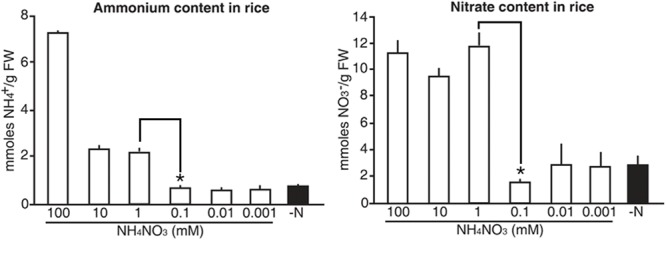
Internal levels of ammonium and nitrate that vary upon exogenous application of N sources in rice. Levels of ammonium and nitrate in wild type rice plants grown on GM–N (growth media –N) for 4 days followed by +N at 0, 0.001, 0.01, 0.1, 1, 10, or 100 mM ammonium nitrate for 1 day. Data shown are the mean + SD of two biological and three technical replicates. Asterisks indicate significant differences based on a 95% confidence interval by a Student’s t-test.